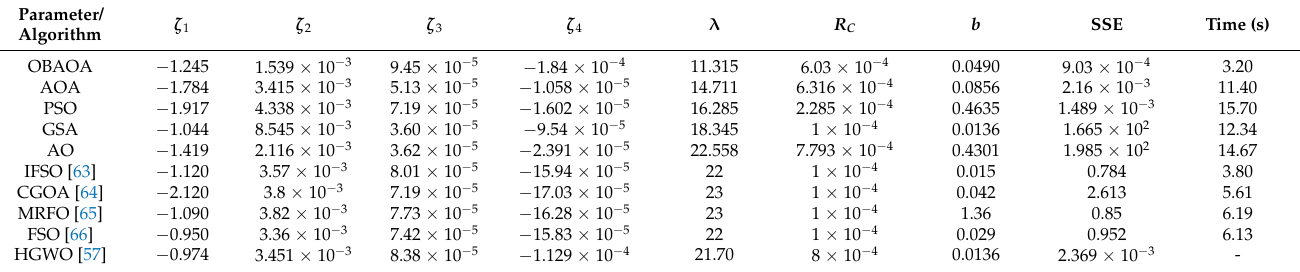
Table 5. Optimized value of parameters for Ballard Mark V PEM fuel